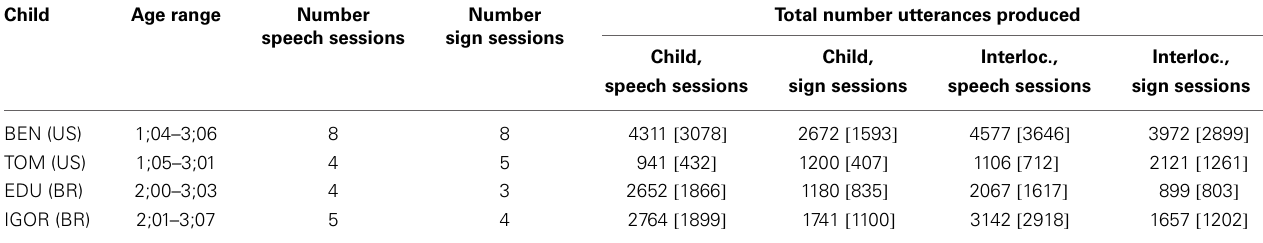
Table 1 | Participant